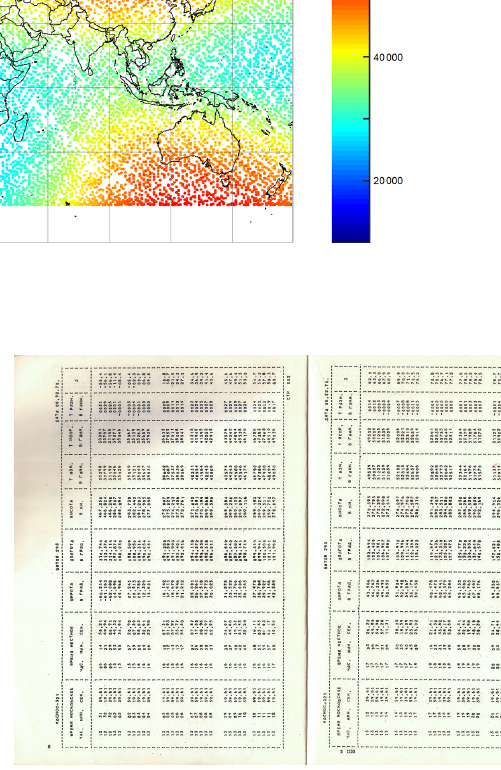
Figure 9. A sample page of the Kosmos-321 catalog (Dolginov et al.,